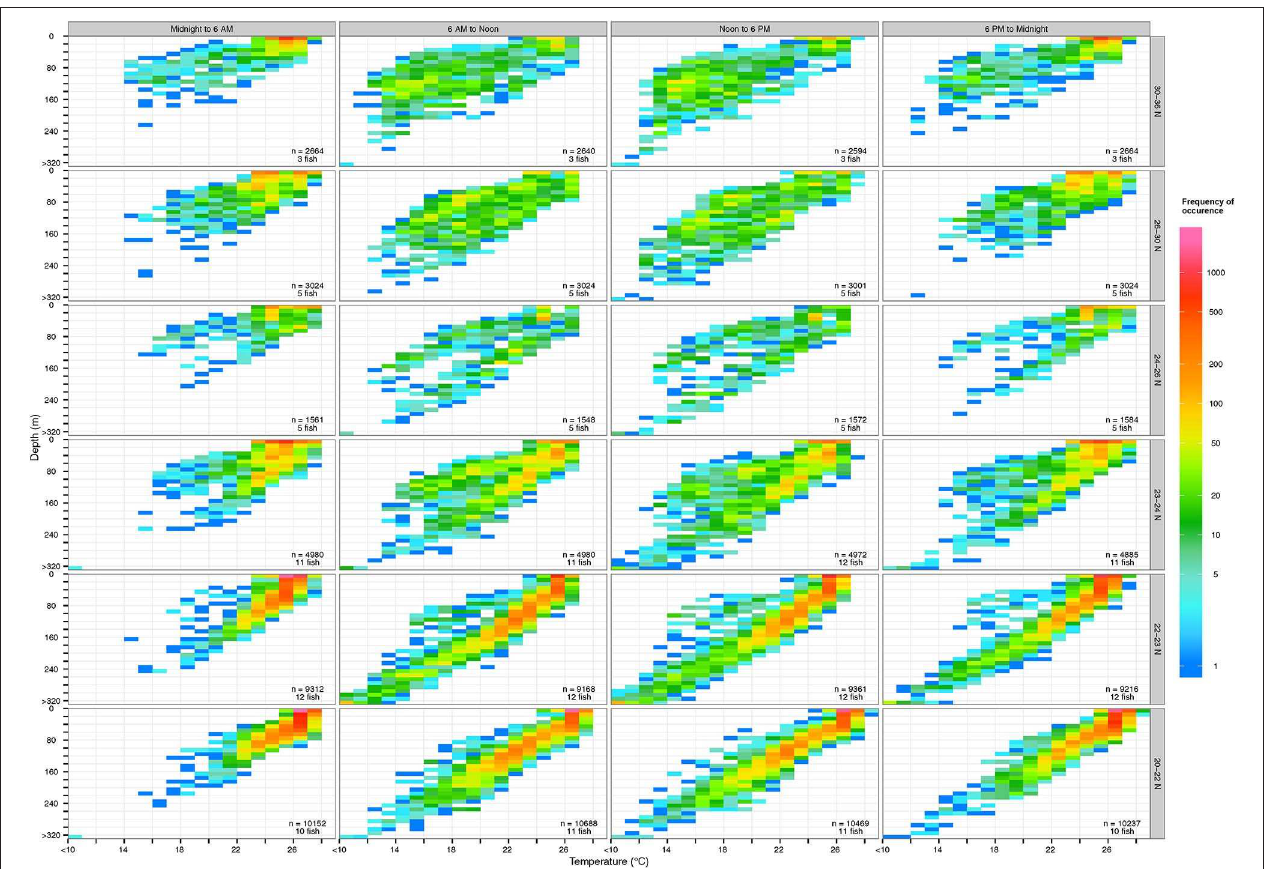
FIGURE 5 | Vertical habitat of tagged yellowfin over 6-h periods at various latitudinal bands. Colors in logarithmic scale represent frequency of occurrence (i.e., count). The number of samples and individuals contributing to depth-temperature values are indicated in each subplot. Depths were binned every 10m and values deeper than 320m were aggregated into the > 320-m bin. Temperatures were binned every 1 ◦ C and values below 10 ◦ C were aggregated into the < 10 ◦ C